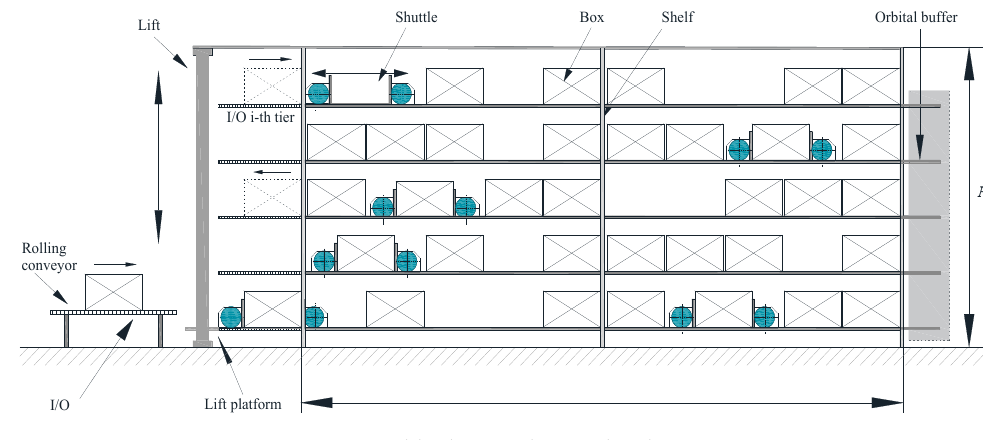
Figure 2. Double-deep multi-tier shuttle system .